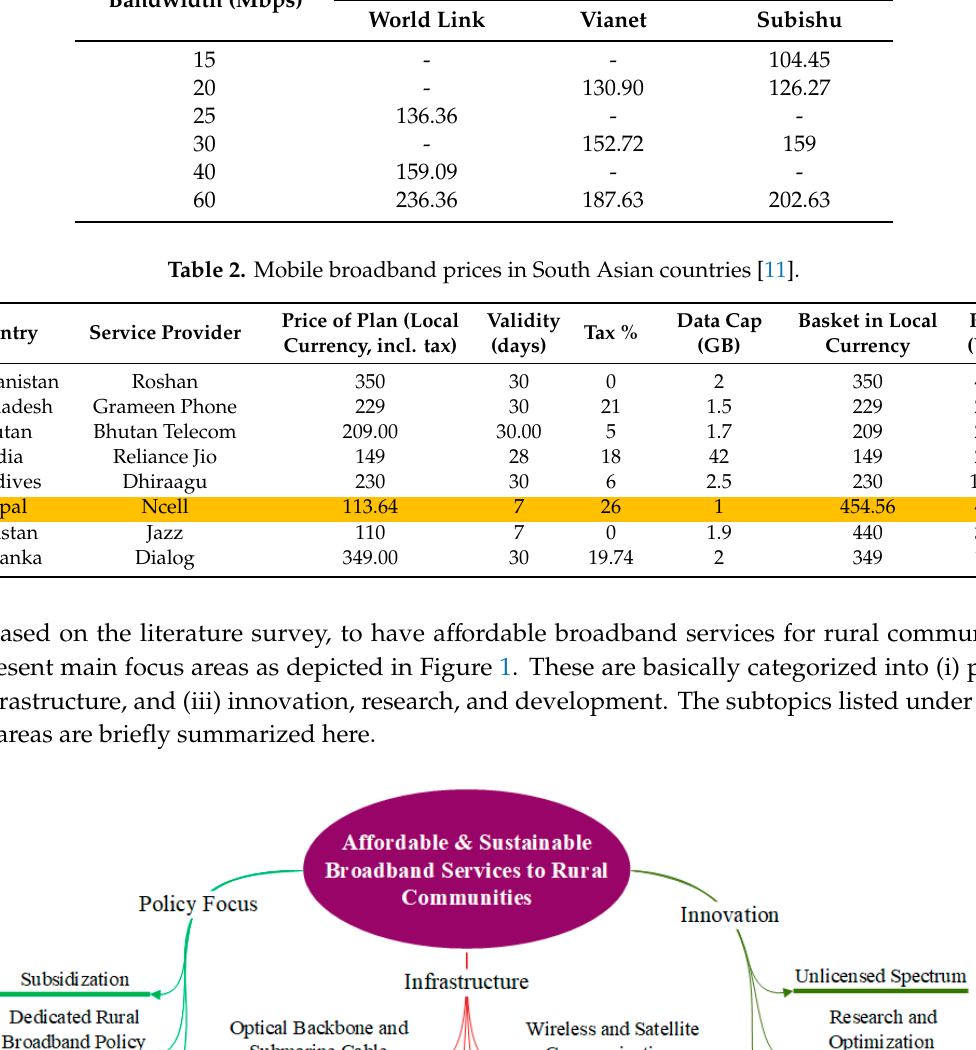
Table 1. Fix broadband prices of major ISPs of Nepal (As of March 2019, www.worldlink.con.np